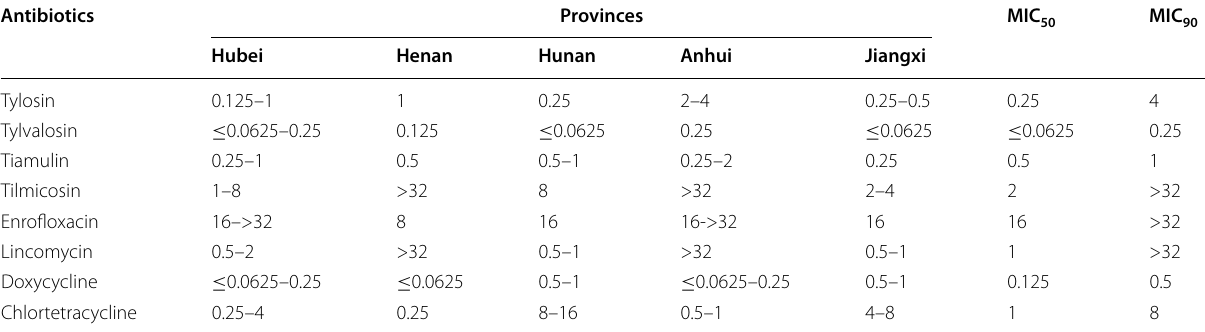
Antibiotics were tested in the concentration range 0.0625–32 μg/mL. All MIC values are expressed in μg/mL and values that were below or above the dilution range are marked as or >, respectively. MIC 50 values indicate the concentration that inhibited 50% isolates. MIC 90 values indicate the concentration that inhibited 90% ≤